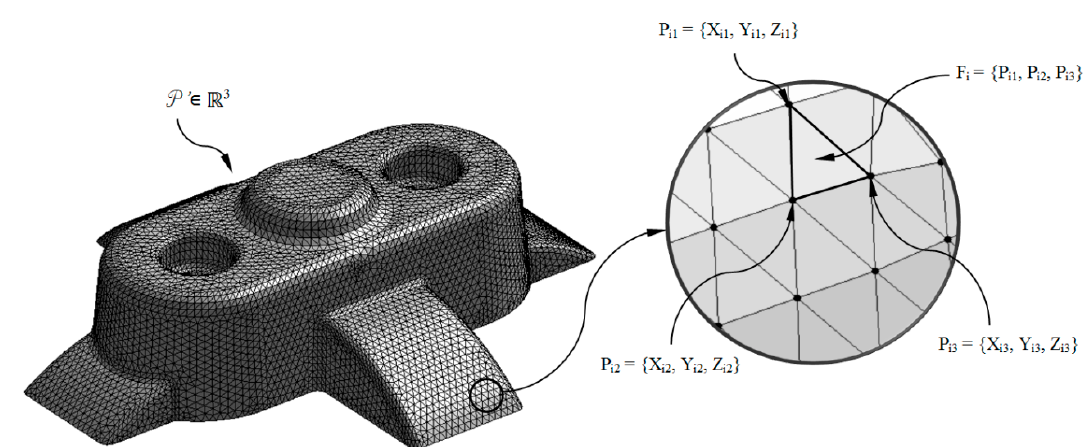
Figure 2. Discrete geometry P’ ∈ ℝ 3 of the plastic part and detail of a triangular facet F i and the nodes P i1 , P i2 , P i3.